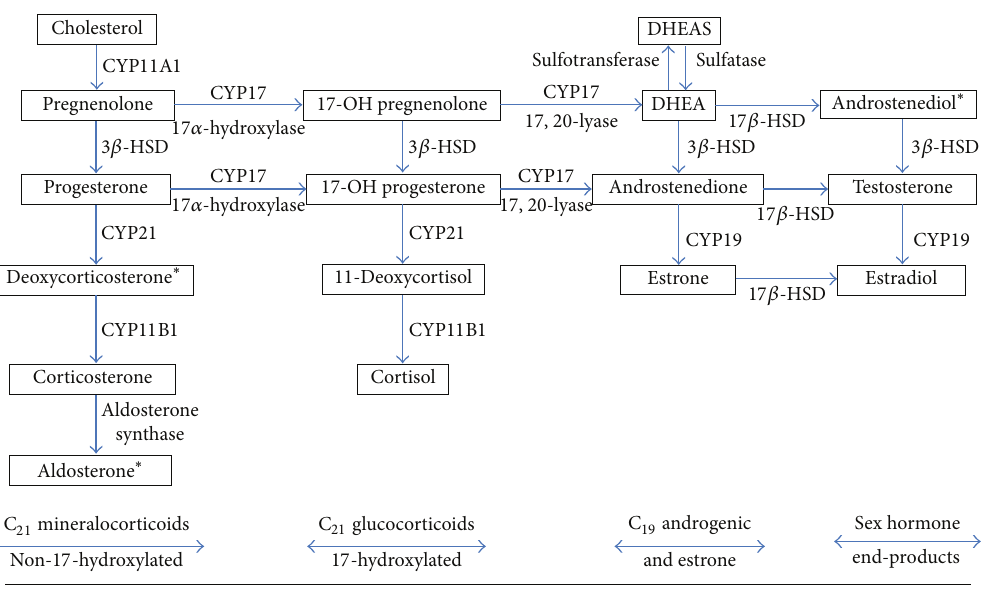
(Fraction B1). This fraction contained cortisol (F), deoxy- cortisol (DF), corticosterone (cmpd B), deoxycorticosterone (DOC), estrone (E1), and estradiol (E2). The third